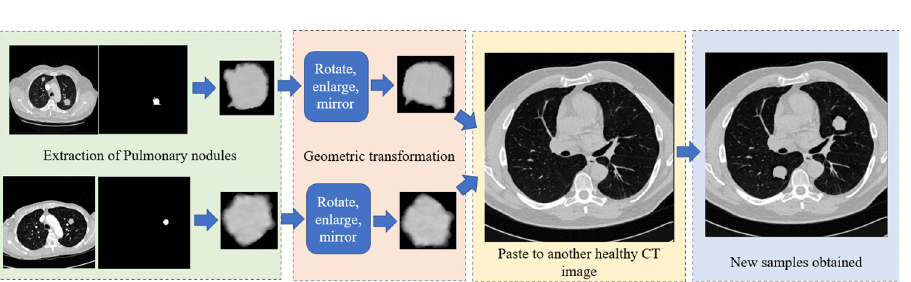
Fig 5. Specific process of multiple oversampling fusion augmentation method.